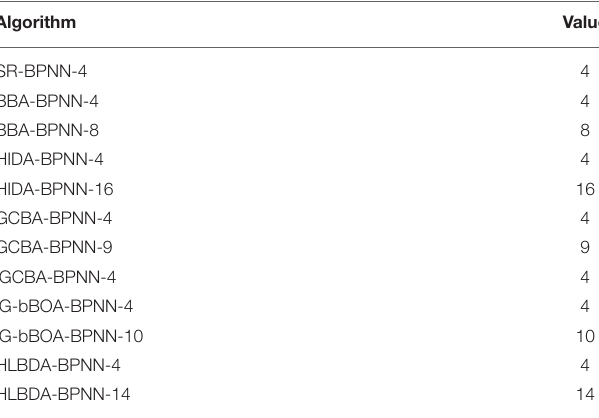
TABLE 4 | The number of hidden layer nodes in BPNN. Algorithm